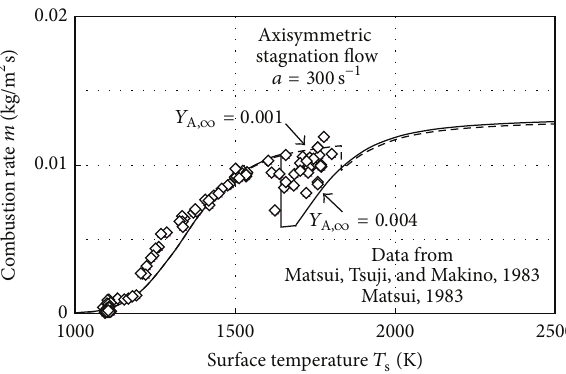
Figure 8: Combustion rate as a function of the surface temperature, taken as a parameter. Data with the H 2 O mass-fraction 𝑌 A ,∞ pointsarecombustionratemeasuredintheaxisymmetricstagnation airflow over a flat plate [38, 64]; curves are calculated by use of the explicit combustion-rate